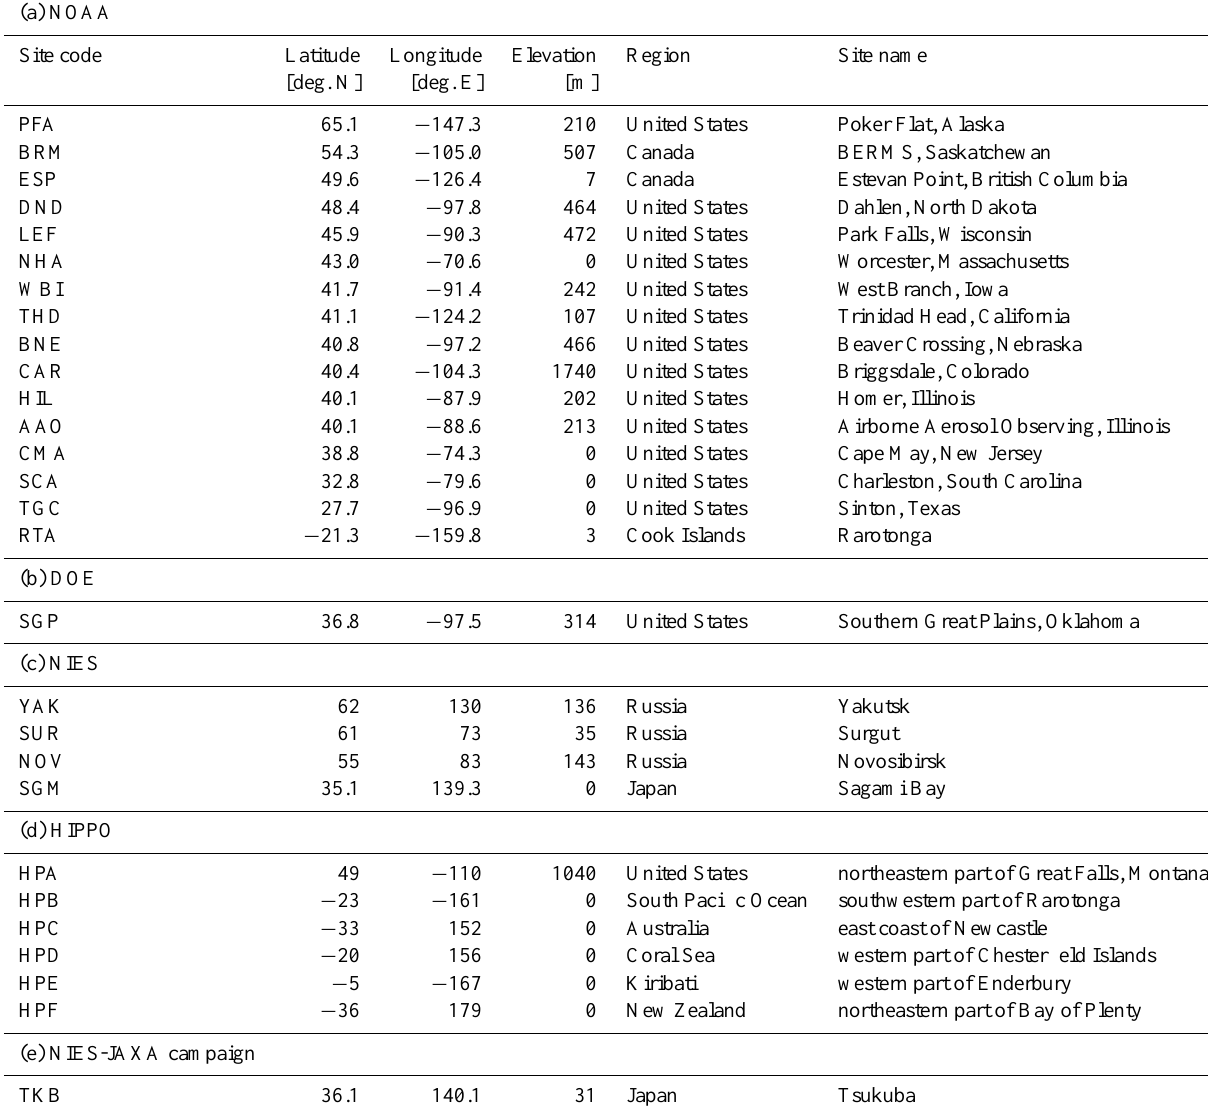
Table 1. Basic information on the aircraft observation sites. (a)